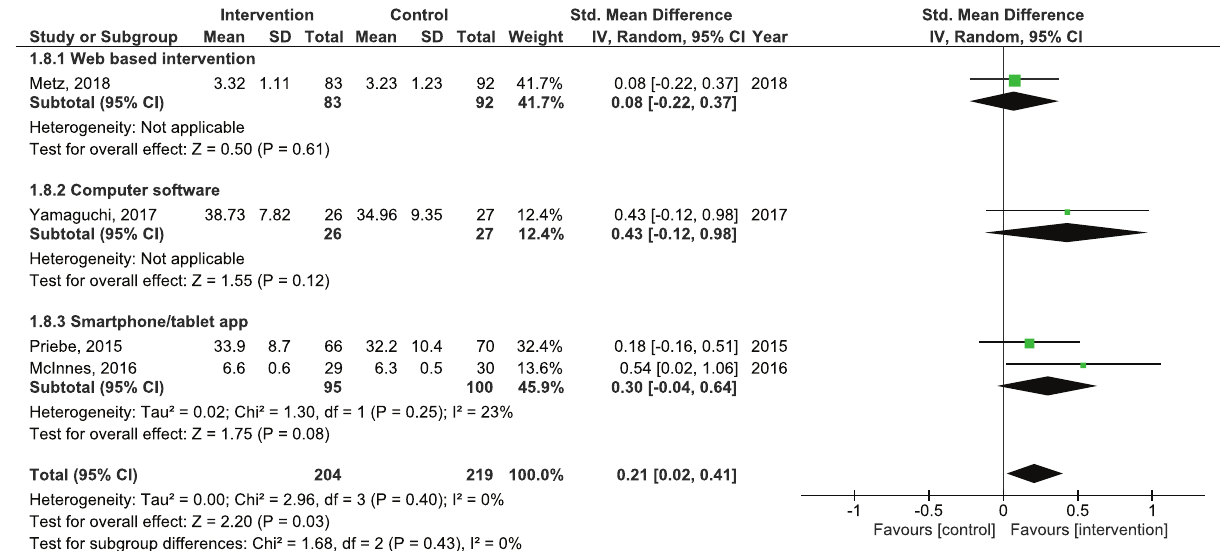
FIGURE 10 | Forest plot for working alliance by type of intervention perceived by the patient.